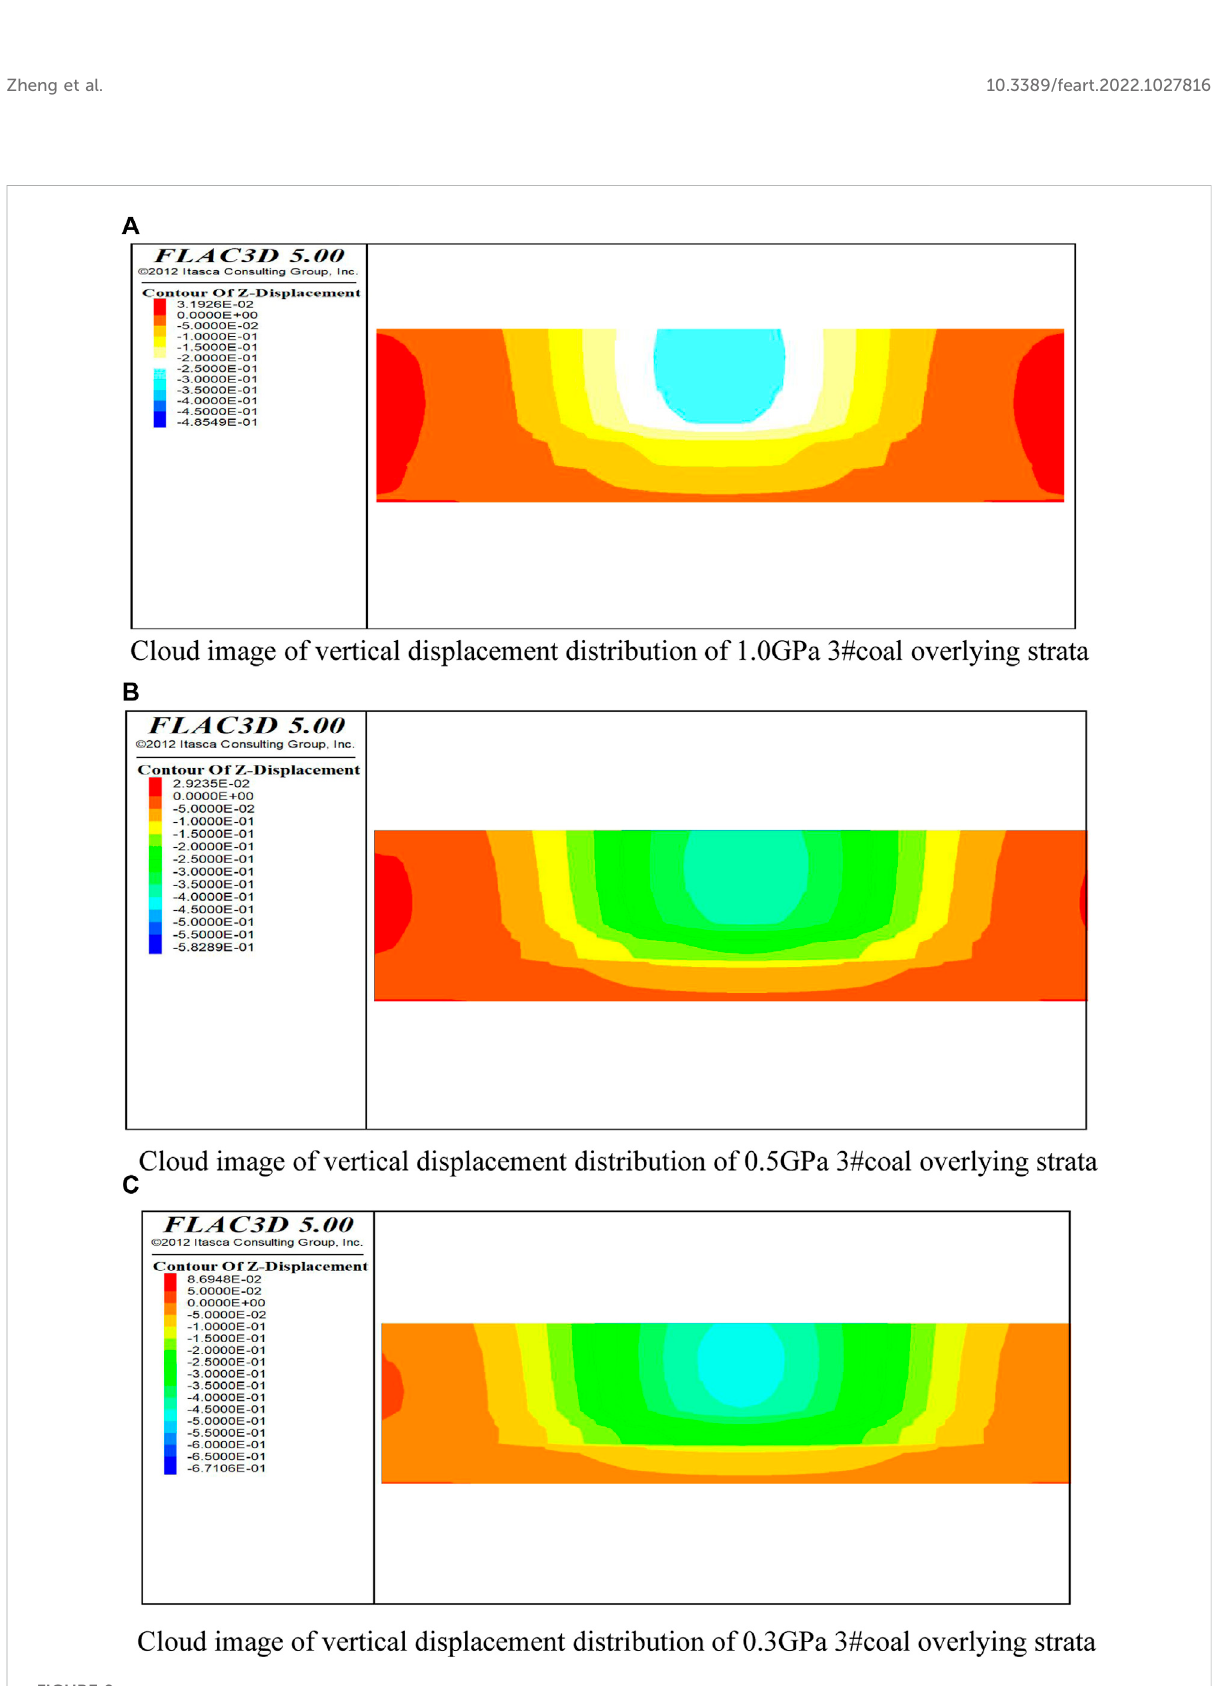
FIGURE 9 Vertical displacement distribution of overlying strata under different back fi ll strengths. (A) Cloud image of vertical displacement distribution of 1.0 GPa3#coaloverlyingstrata. (B) Cloudimageofvertical displacement distribution of0.5 GPa3#coaloverlyingstrata. (C) Cloudimageofvertical displacement distribution of 0.3 GPa 3# coal overlying